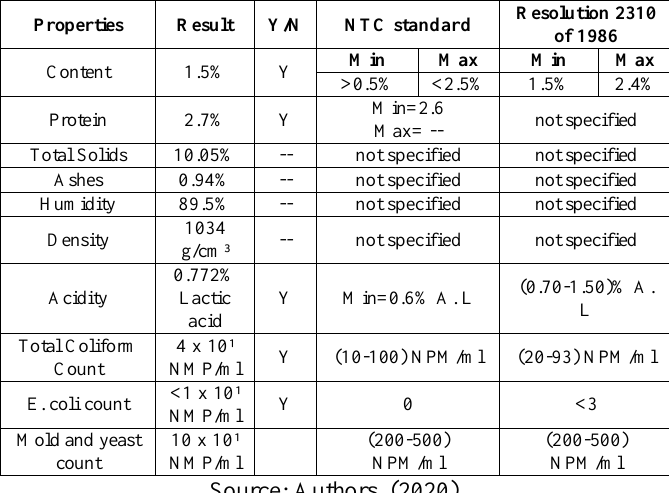
Table 3: Characterization Yogurt produced with experimental